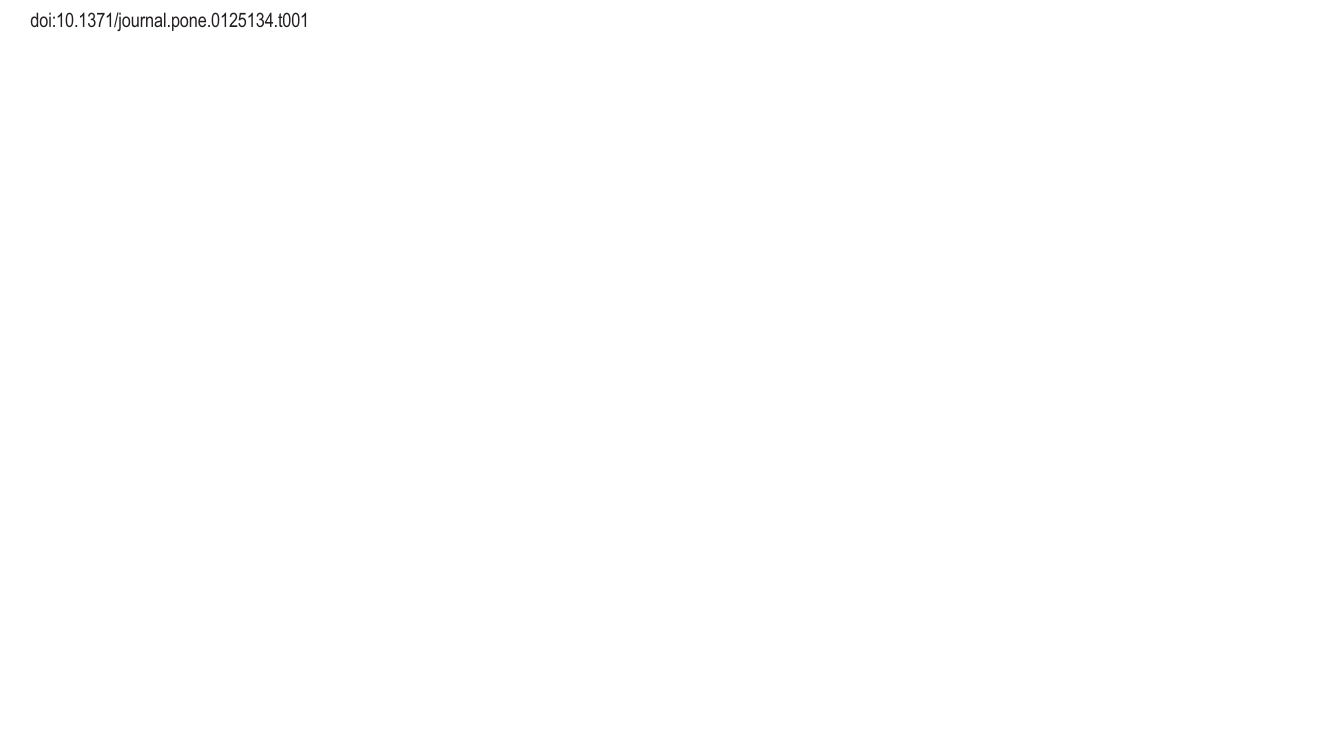
Carbon data for humpback whales are not available Krill samples were homogenates of 5 animals of each species Iron data for all species have been discussed in Nicol